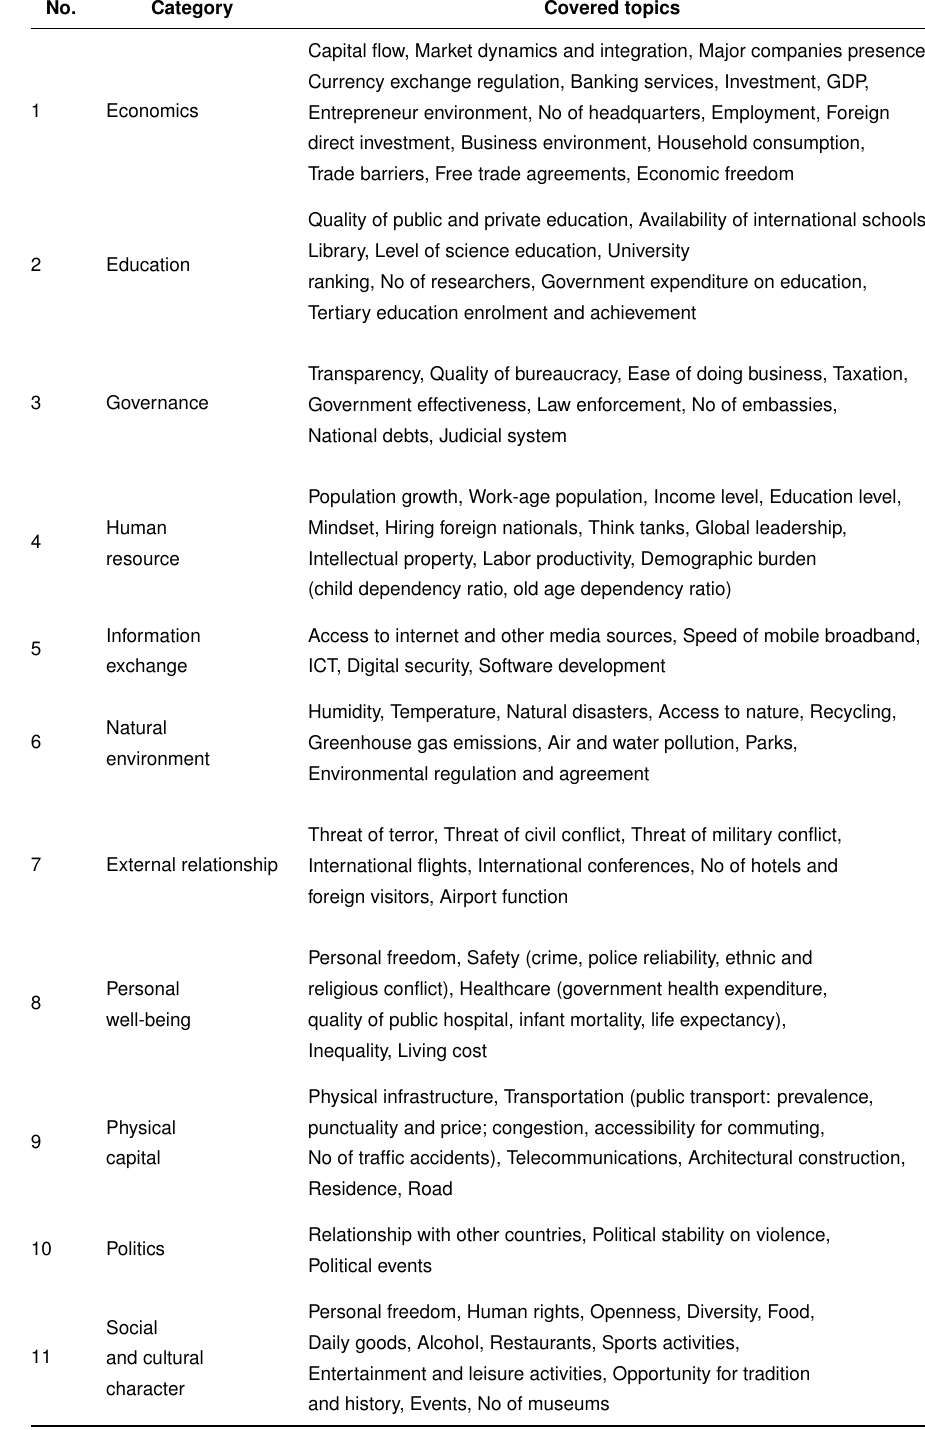
Table 2. Categories and topics that reflect the combined content of the ranking schemes presented in Table 1.